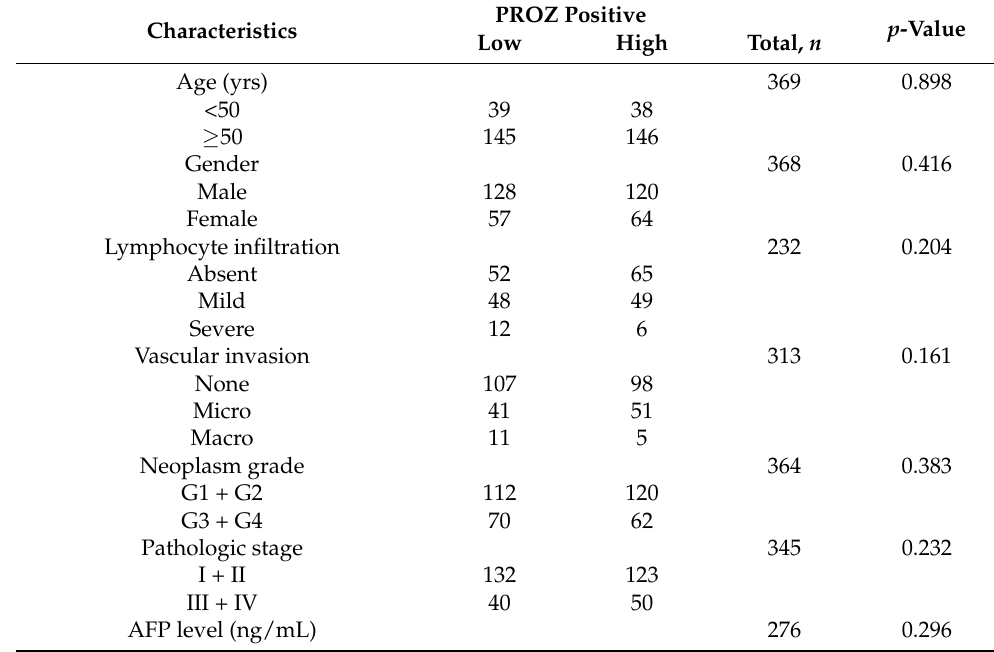
Table 3. PROZ expression status in relation to patient characteristics in